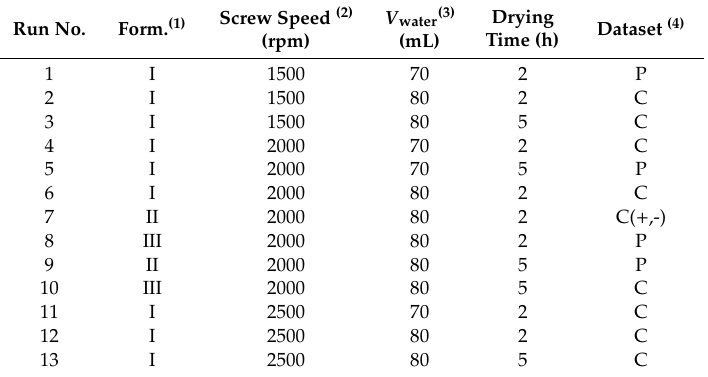
Table 2. High-shear wet granulation and drying process